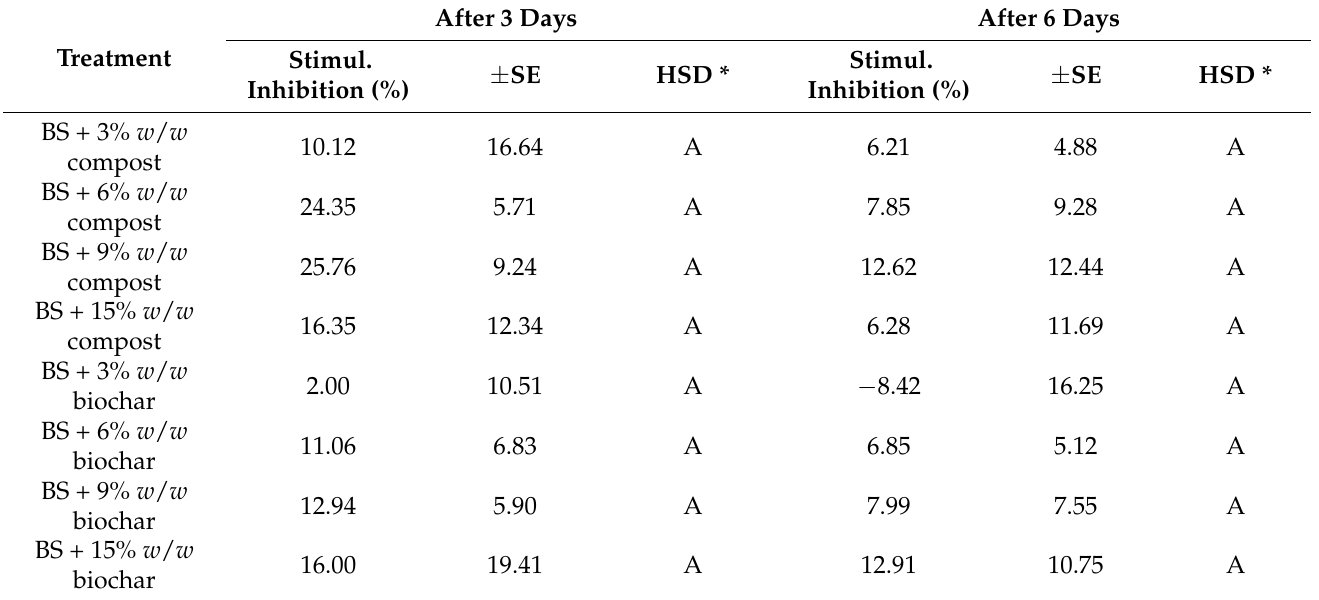
Comment: Different letters indicate significant differences between individual variants within 3 or 6 days of testing. Sym ‐ bol * represents significant differences between 3 and 6 days of testing within one variant.